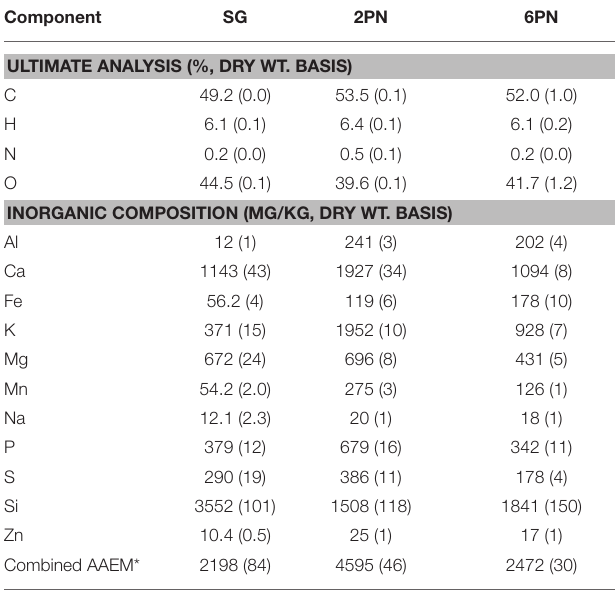
TABLE 3 | CHNO content and inorganic composition of feedstock biomass.